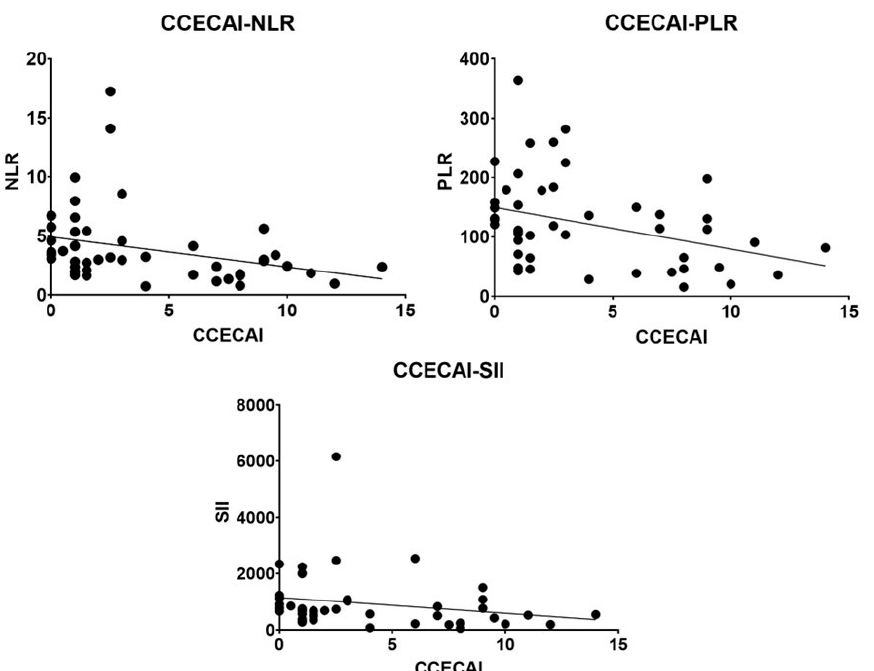
Figure 3. Correlation between CCECAI and each white blood cell-based inflammatory marker.